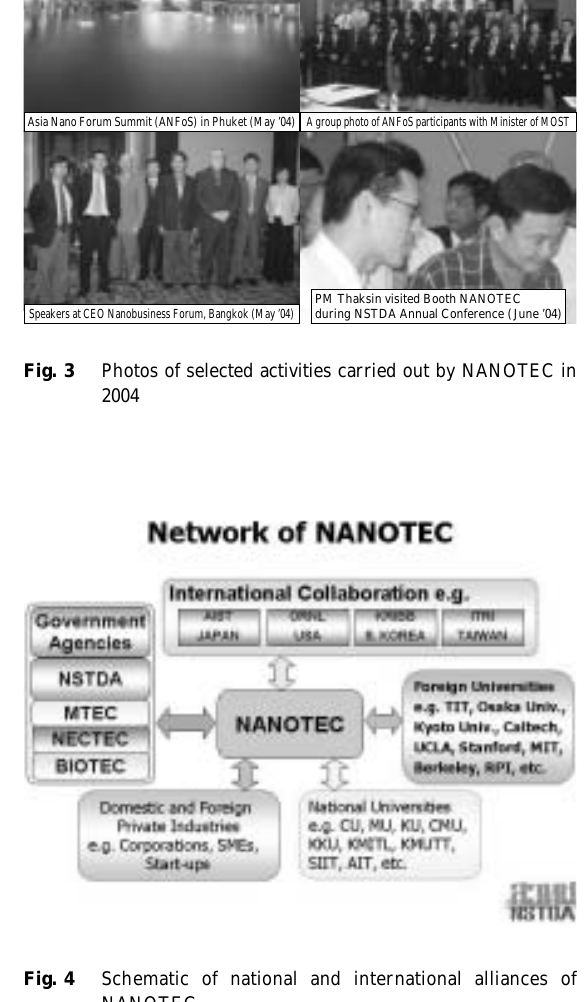
Asia Nano Forum Summit (ANFoS) in Phuket (May ’04)